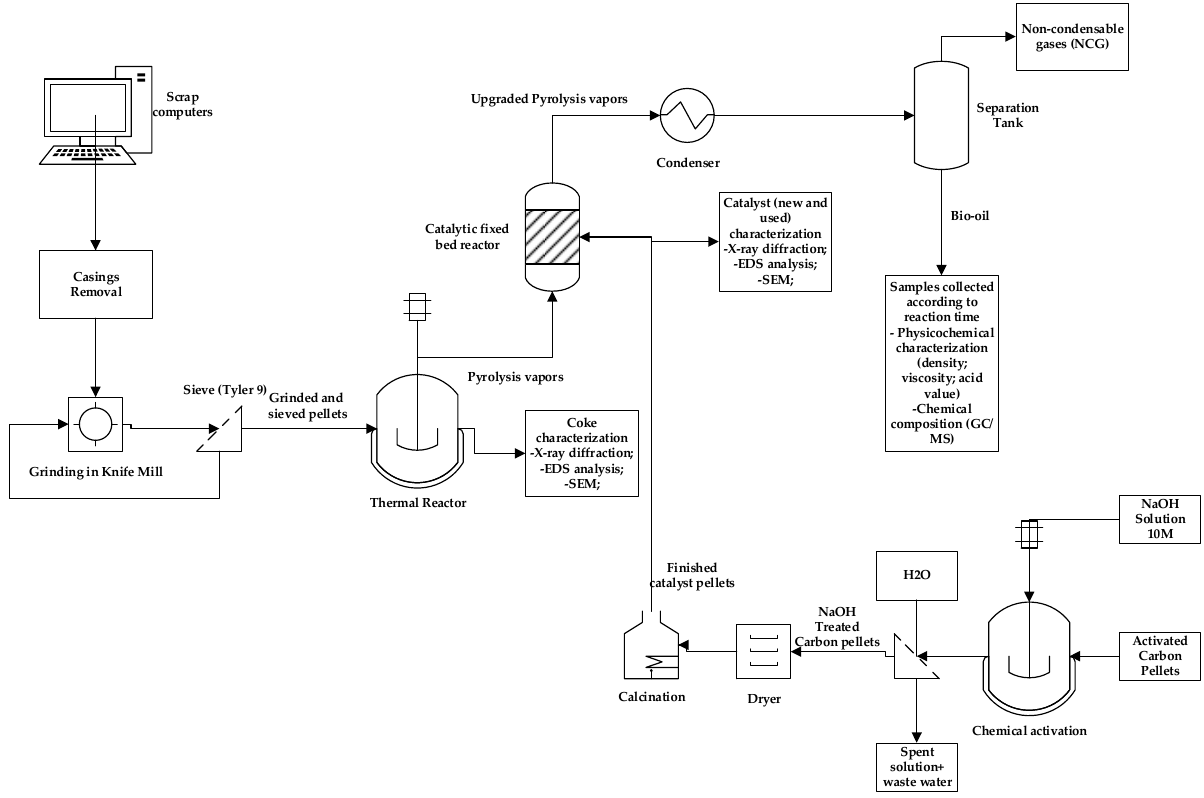
Figure 1. Process flowchart of catalytic upgrading of WEEE vapors using Si–Al ash catalyst pellets, in semi-pilot scale.